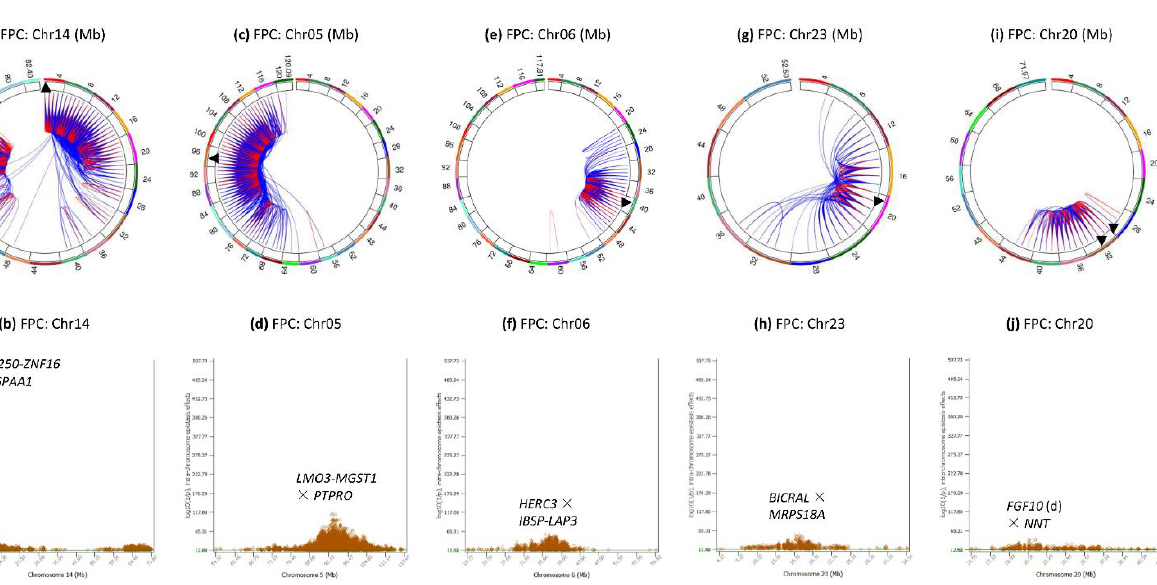
Figure 3. Chromosomes with most significant intra-chromosome epistasis effects for fat percentage. The top row shows the circular plots with red color indicating intra-4 Mb epistasis effect and blue color indicating inter-4 Mb epistasis effects; the bottom row shows the Manhattan plots of log10(1/p) values, where p = the 5% genome-wide type-I error with the Bonferroni multiple testing correction. The black arrow indicates the location of the peak epistasis effect of the chromo- some. Gene name indicates the gene with a peak SNP epistasis effect, and ‘ - ’ indicates the SNP was between the two genes. FPC = fat percentage. ( a ): Intra-chromosome epistasis effects of Chr14 for fat percentage. ( b ): Statistical significance of intra-chromosome epistasis effects of Chr14 for fat percentage. ( c ): Intra-chromosome epistasis effects of Chr05 for fat percentage. ( d ): Statistical significance of intra-chromosome epistasis effects of Chr05 for fat percentage. ( e ): Intra-chromosome epistasis effects of Chr06 for fat percentage. ( f ): Statistical significance of intra-chromosome epistasis effects of Chr06 for fat percentage. ( g ): Intra-chromosome epistasis effects of Chr23 for fat percentage. ( h ): Statistical significance of intra-chromosome epistasis effects of Chr23 for fat percentage. ( i ): Intra-chromosome epistasis effects of Chr20 for fat percentage. ( j ): Statistical significance of intra-chromosome epistasis effects of Chr20 for fat percentage.